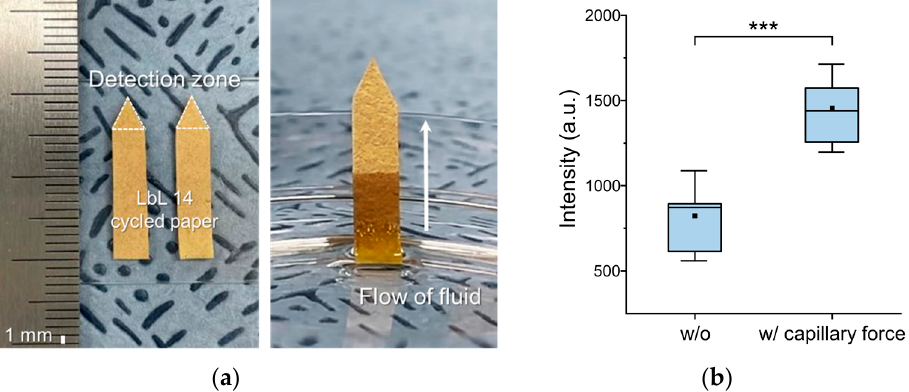
Figure 8. ( a ) Photograph of LbL paper substrate cut into an arrow shape with a lateral transportation and detection zone where the sample liquid moves and is vaporized, consequently focusing analyte molecules on the tip; ( b ) Signal enhancement by simply cutting the LbL paper substrate (black dot, mean; black solid line in box, median; box height, sample variability from 25% to 75%; error bar, standard deviation; *** p < 0.001).